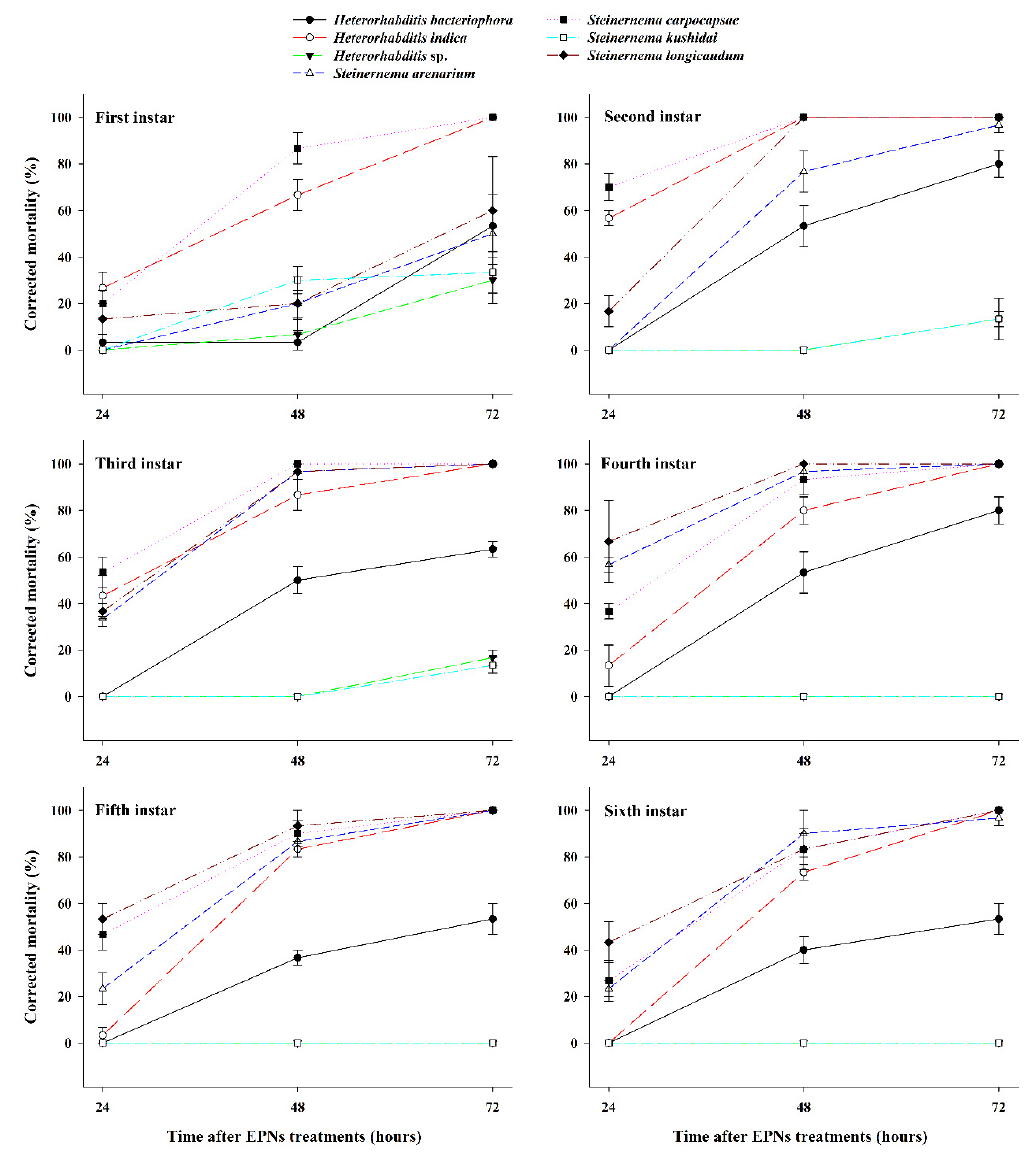
Figure 1. Corrected mortality caused by seven entomopathogenic nematodes (EPNs) in the larval stages of Spodoptera frugiperda . EPNs at a concentration of 50 infective juveniles per larva were applied to different larval stages of S. frugiperda and mortality rates were determined after 24, 48, and 72 h. Table 1. ANOVAparametersfortheindividualeffectsoflarvalstage,post-treatmenttime,entomopathogenic nematode species, and their associated interactions on the mortality of Spodoptera frugiperda larvae over 72 h.